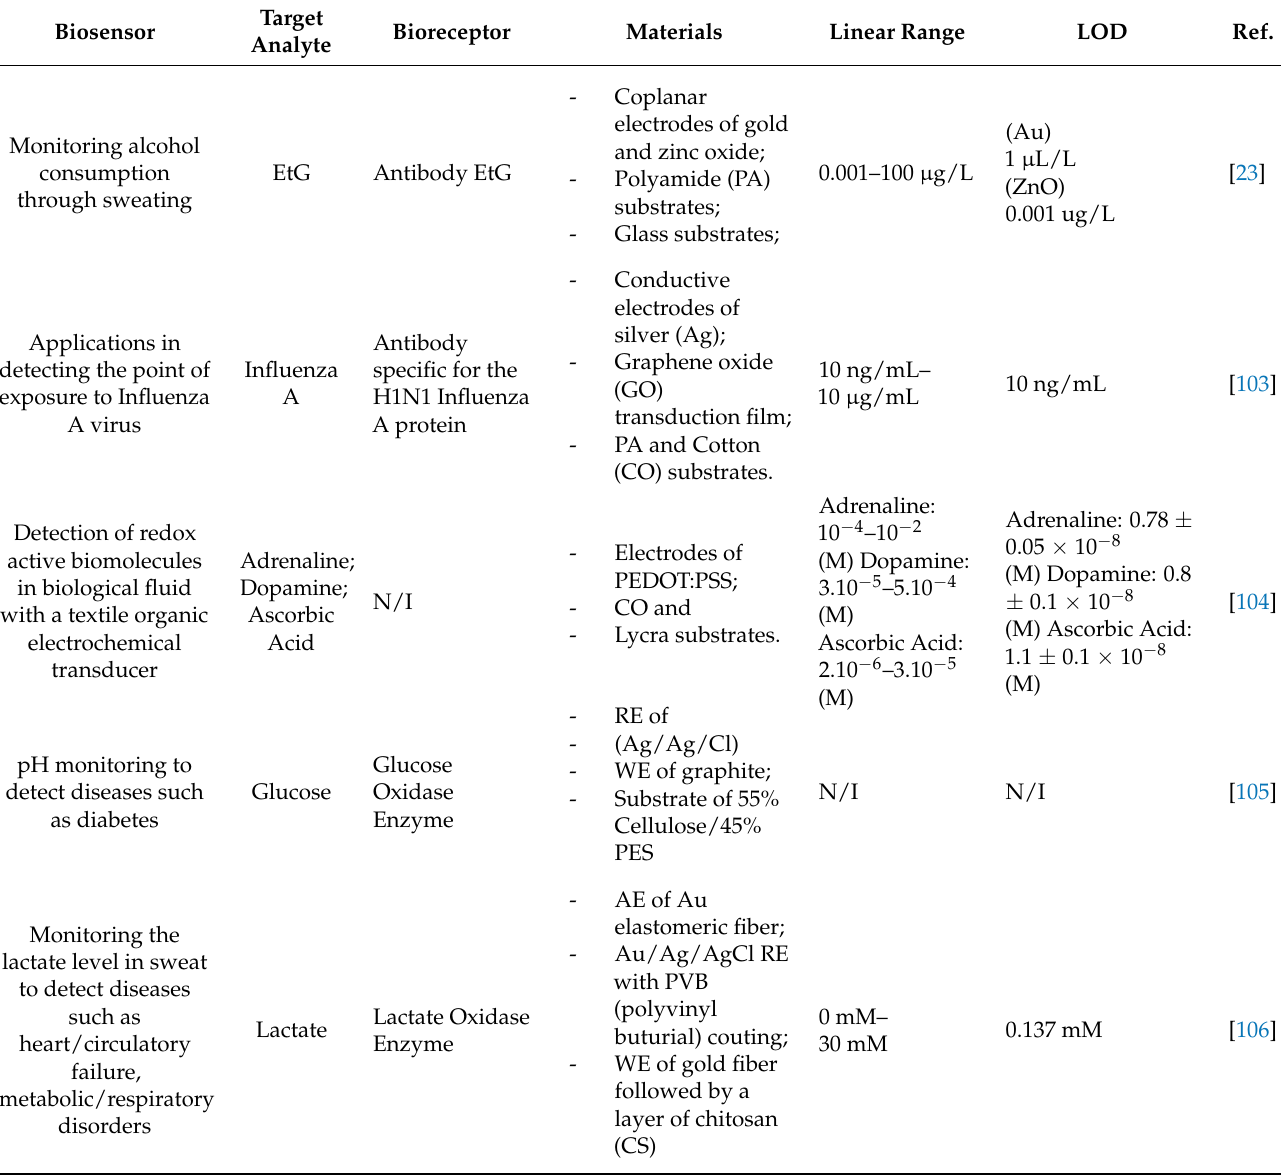
Table 5. Represents the list of various materials employed in the development of flexible biosensors. Note_ N/I means No